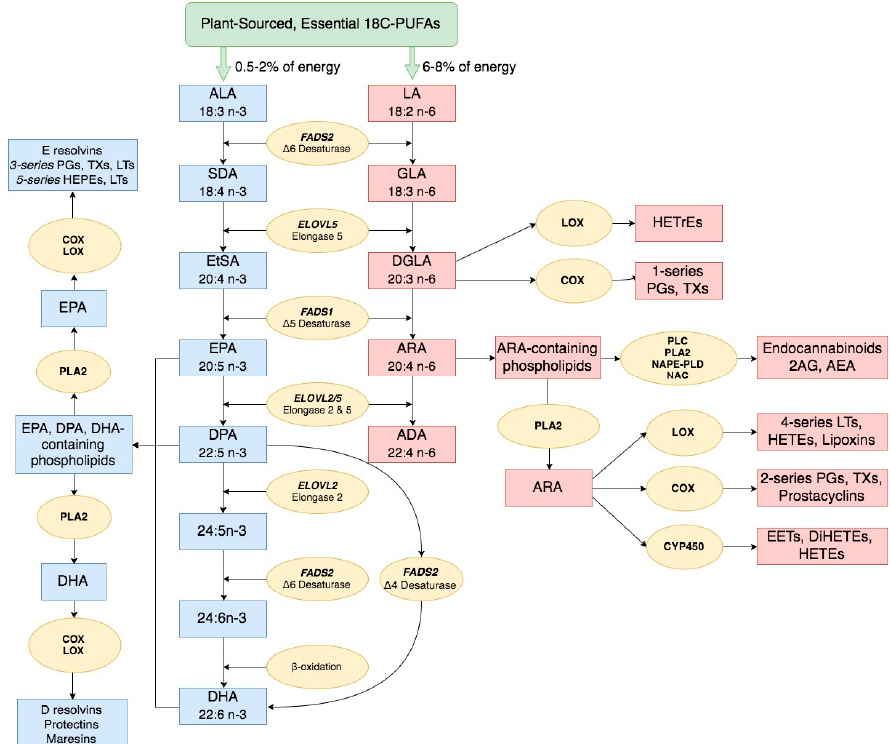
Figure 1. Polyunsaturated fatty acid biosynthesis. n -3 and n -6 LC-PUFA are synthesized from dietary intake of essential fatty acids ALA and LA, respectively, through a series of enzymatic desaturation ( FADS2 and FADS1 ) and elongation ( ELOVL2 and ELOVL5 ) steps. This pathway gives rise to primary n -3 LC-PUFAs and n -6 LC-PUFAs such as EPA, DPA, DHA and ARA. These LC-PUFAs (as free fatty acids or complex lipids) and their metabolites impact a wide ranges of physiologic and pathophysiologic